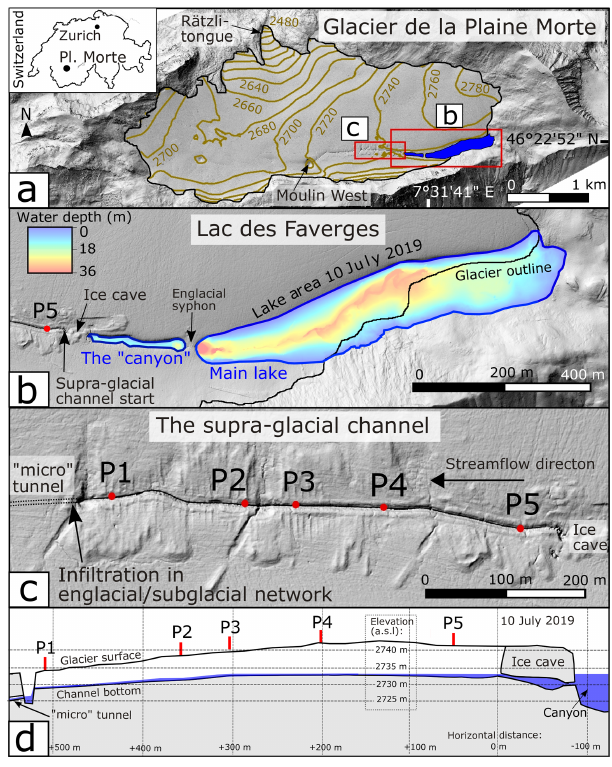
Figure 1. (a) Map of Glacier de la Plaine Morte where the ice- dammed Lac des Faverges lake is located. The lake area displayed in (b) corresponds to the maximum lake size reached on 10 July 2019 (at a lake level of 2733.15ma.s.l). The supraglacial channel and the measurement stations P1 to P5 are presented in (c) and (d) . The longitudinal profile in (d) was reconstructed from sparse elevation measurements of the glacier surface and channel bottom prior to supraglacial lake drainage; the ice cave was not mapped, and its representation is indicative only. The digital elevation model used in this figure was created from post-drainage aerial images acquired by the Swiss Federal Office of Topography on 3 September 2019 (see Sect. 3 for more